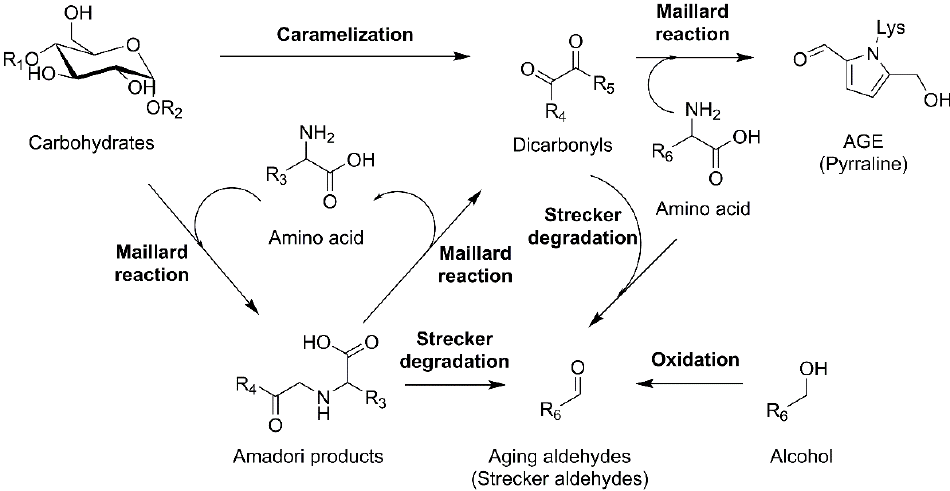
Figure 1. Overview of observed de novo formation pathways of aging aldehydes.